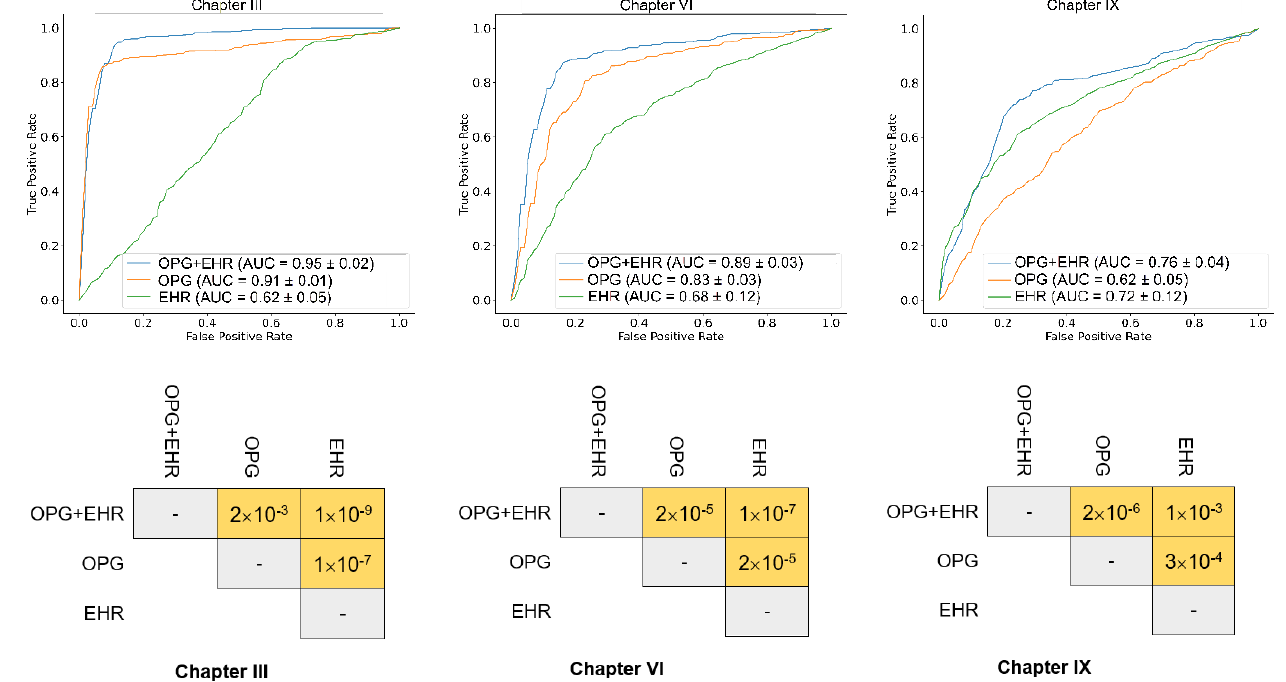
Figure 4. AU-ROCs of the 14 trained models. The results show the model has the best performance for the Chapters III, VI and IX.